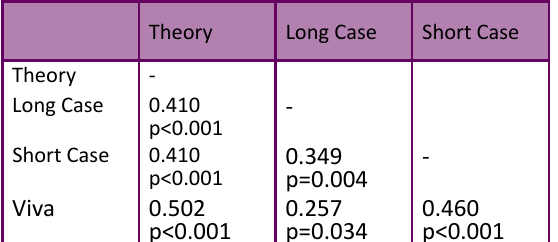
Table 3– Correlation of marks of different components of the examination Theory Long Case